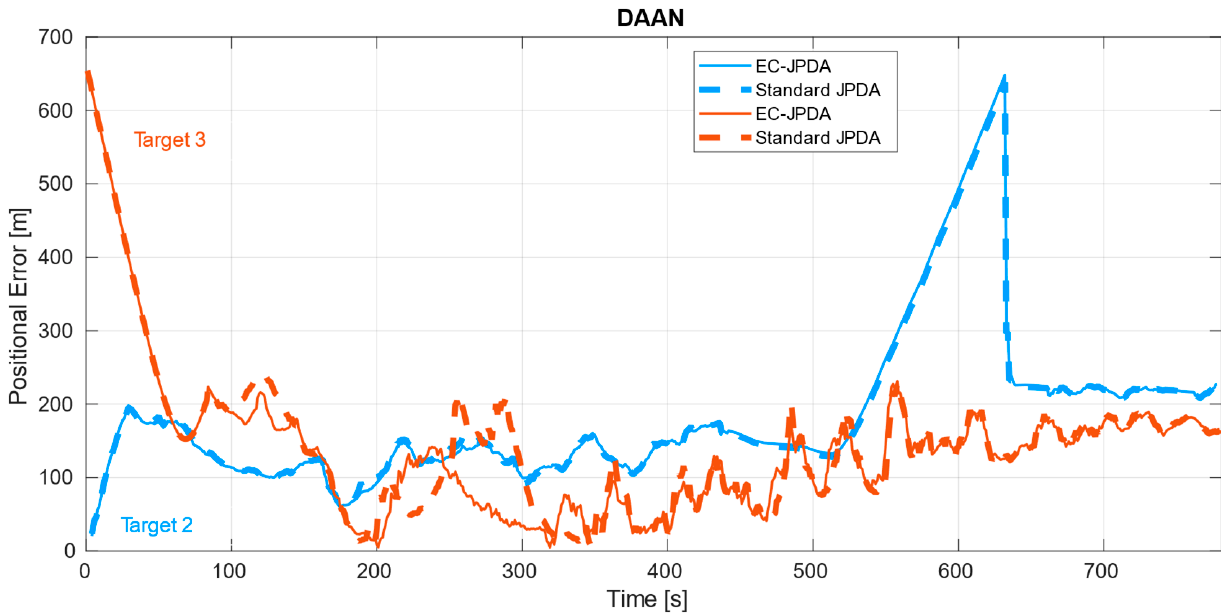
Figure 7. The positional error of the two targets in DAAN.